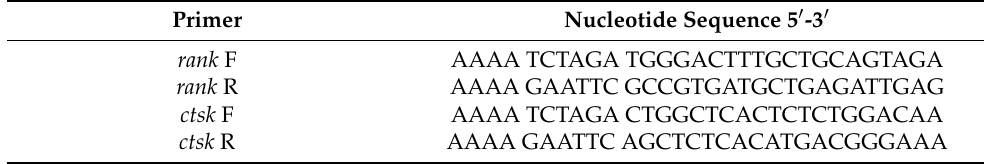
Table A2. Nucleotide sequence of primers used for the